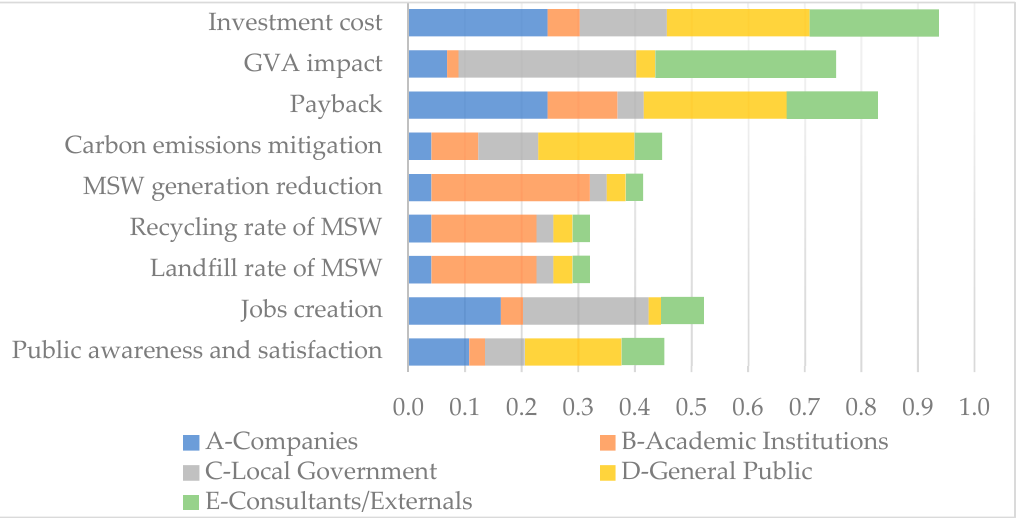
Figure 3. Subjective weight values for stakeholders.